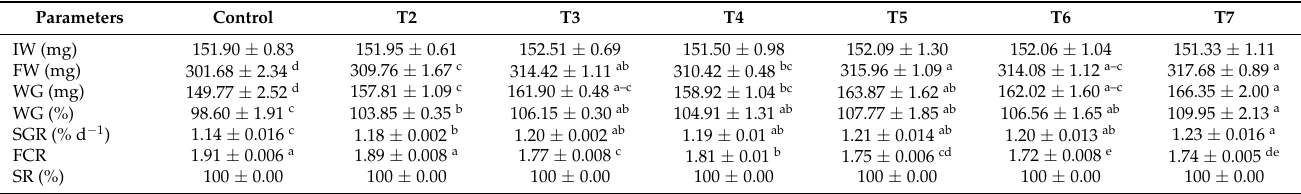
Table 1. Growth performance of zebrafish fed on diets with different levels of synbiotic Biomin ® IMBO and/or Persian shallot for 60 days. T1, control (without any supplementation); T2, 1% synbiotic; T3, 3% synbiotic; T4, 1% Persian shallot; T5, 3% Persian shallot; T6, 1% Persian shallot and 1% synbiotic; T7, 3% Persian shallot and 3% synbiotic.